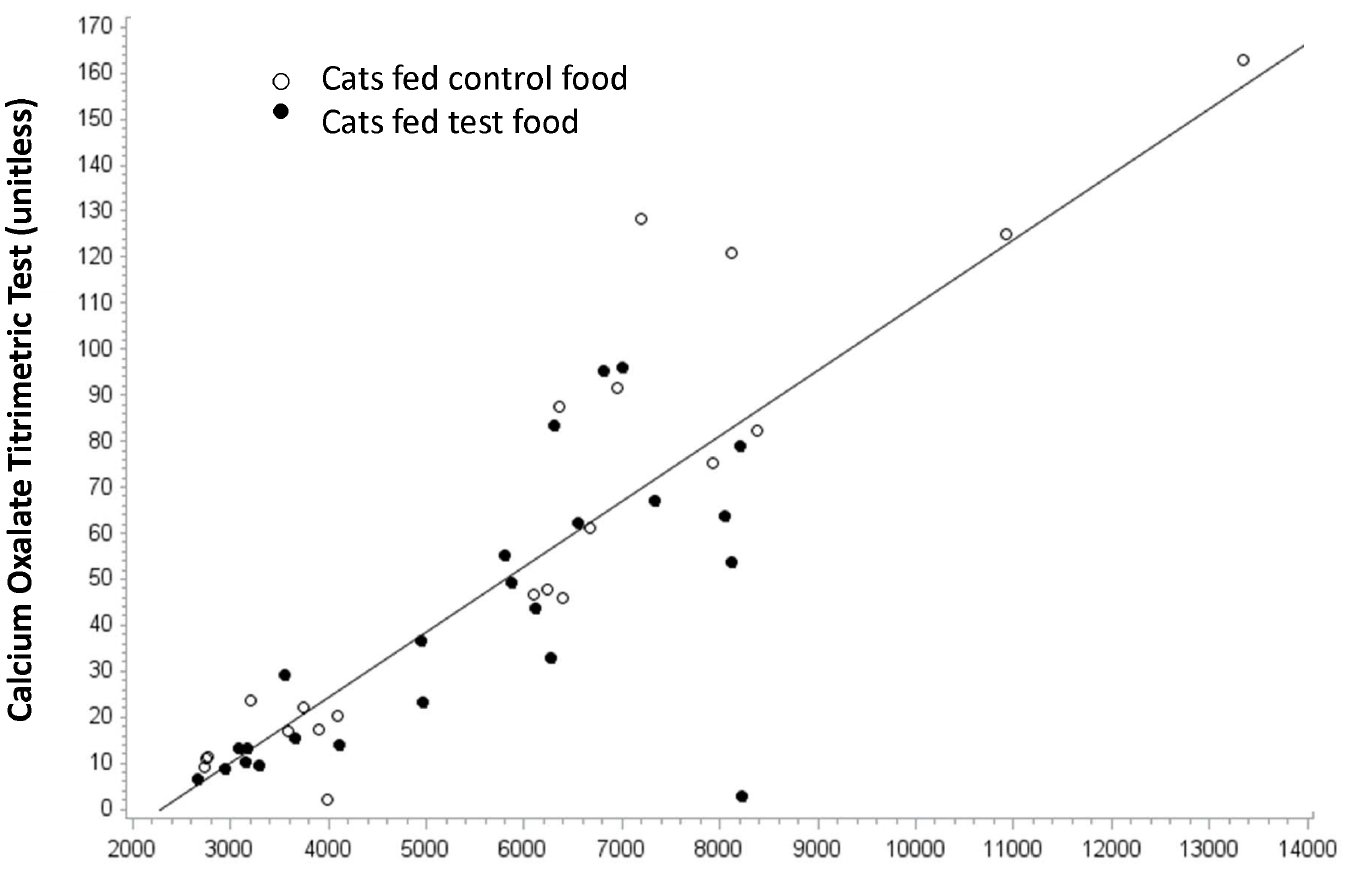
Fig 2. Calcium oxalate titrimetric test. The risk of oxalatecrystal formation as determined by the calcium oxalatetitrimetric test (COT; y-axis) is predicted using fractional excretionof calcium ( P = 0.006) and urine specific gravity ( P = 0.046) measurements (interaction P = 0.005; x-axis). Each cat ( n = 12) is representedtwice by an open circle, for 28 and 56 days on control food, and twice by a filled circle, for 28 and 56 days on test food. Feedingtest food decreased fractional excretionof calcium and decreased urine specific gravity, together both of which increasedresistance to oxalate crystal formation ( r 2 = 0.72; P < 0.001).Note that there are fewer cats fed test food in the upper right quadrantof the graph.